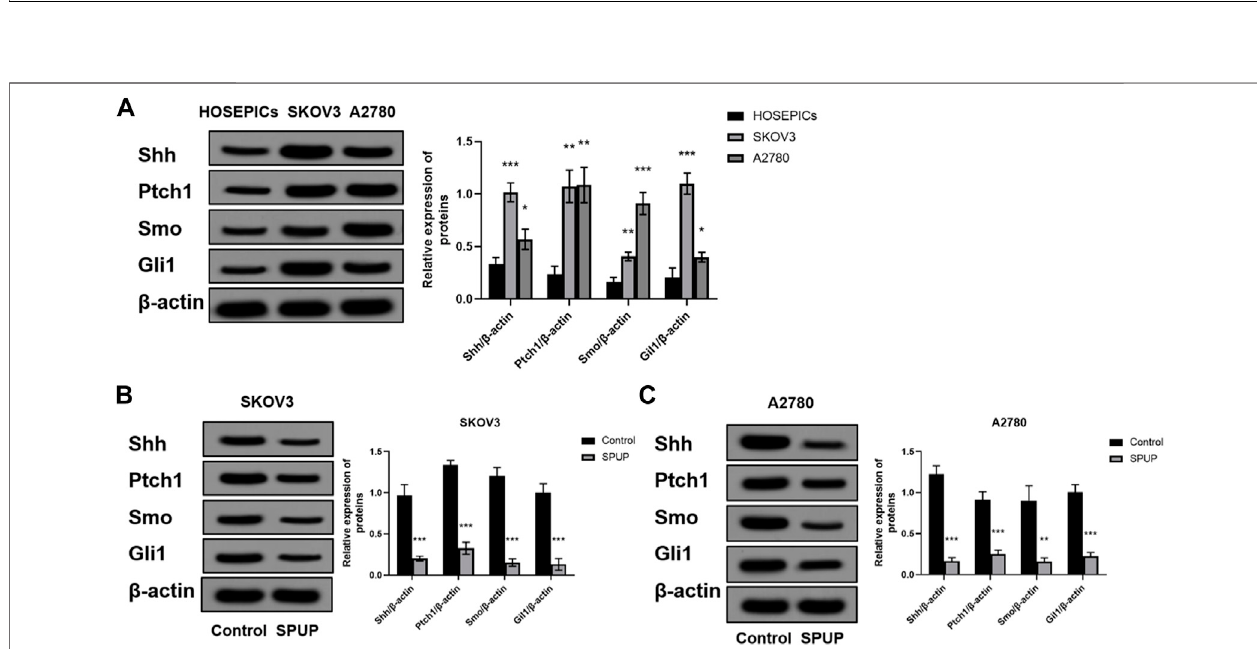
FIGURE5 | Effects ofSPUP on apoptosis of twokinds ofOCcells and humannormal ovarian epithelial cells. *** p < 0.001compared withthe control group. SPUP inhibited the activation of the hedgehog signaling pathway in OC cells.